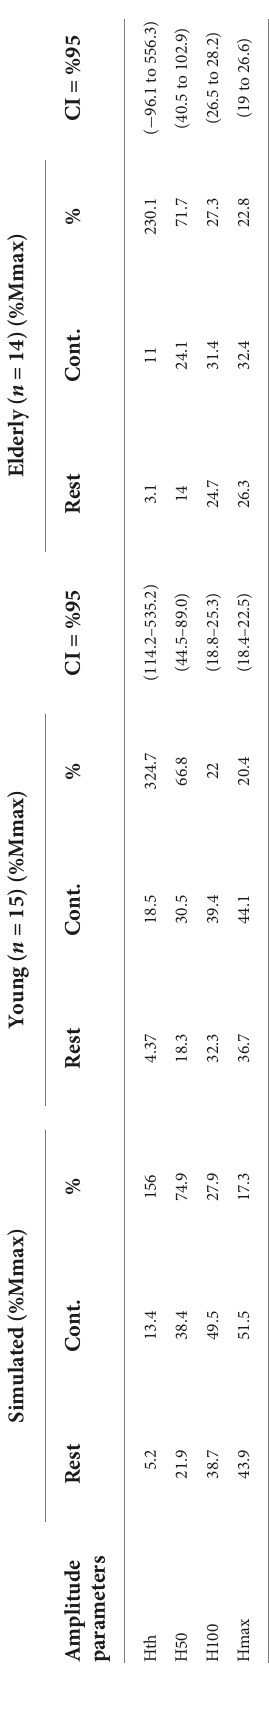
( Figure 3A ), the elderly ( Figure 3B ), and the simulated data ( Figure 3C ). It is possible to observe a consistent increase in amplitude during contraction as compared to the rest condition: compare the traces and points in black (rest) with those in gray (contraction). The same parameters from the curve fitting to the experimental data were also estimated for the simulated data and are presented in Table 3 . The inset in each panel of Figure 3 shows a sweep depicting the M wave and the H-reflex obtained at rest and during contraction. These data referred to the points of RC nearest to H50 (rest) and H@50 (contraction), as well as H100 and H@100 (bottom traces). Figure 3D shows the RC obtained during contraction (same data from Figure 3A ) along with the background EMG (EMGb) (open circles). Note that the EMGb is constant at around 15% MVC for all intensities and amplitude values of the H-reflex. This evidenced that changes in H-reflex amplitude were not correlated to the EMGb. Figures 4A, B show, respectively, the number of MNs recruited to compose both the M wave and the H-reflex (depicted in Figure 4E with a black trace), as well as the corresponding membrane potential from two of those MNs (#1 and #400). Figures 4C, D follow the same description as A and B, but during contraction. It is noticeable the increased recruitment of MNs (population coding) in Figure 4C and an increase in the firing rate of both MNs (rate coding) in Figure 4D . During contraction, the number of MNs recruited to compose the M wave (motor axons directly activated by the stimulus) is almost the same, however, the recruitment is higher for the H-reflex due to the descending command. By inspecting the membrane potential of the same MN (e.g., MN #400), we observed that at rest the afferent volley produced a compound excitatory post-synaptic potential. It is also interesting to note that during contraction the MNs are not only recruited by the stimulus, but they are activated by the descending drive as well (observe the MNs recruited before the stimulus being delivered, at negative times in the abscissa of Figure 4C ). Those MNs are responsible for the EMGb in Figure 4E (trace in gray), corresponding to 15% of the MVC. The corresponding M wave and H-reflex evoked during contraction are also depicted in Figure 4E (trace in